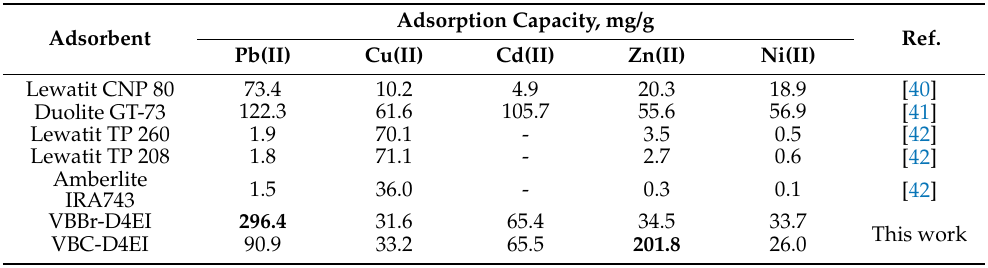
Table 4. Comparison of capacities towards Cu(II), Cd(II), and Zn(II) of the selected adsorbents (pH 4–6). Bold is highlight the best